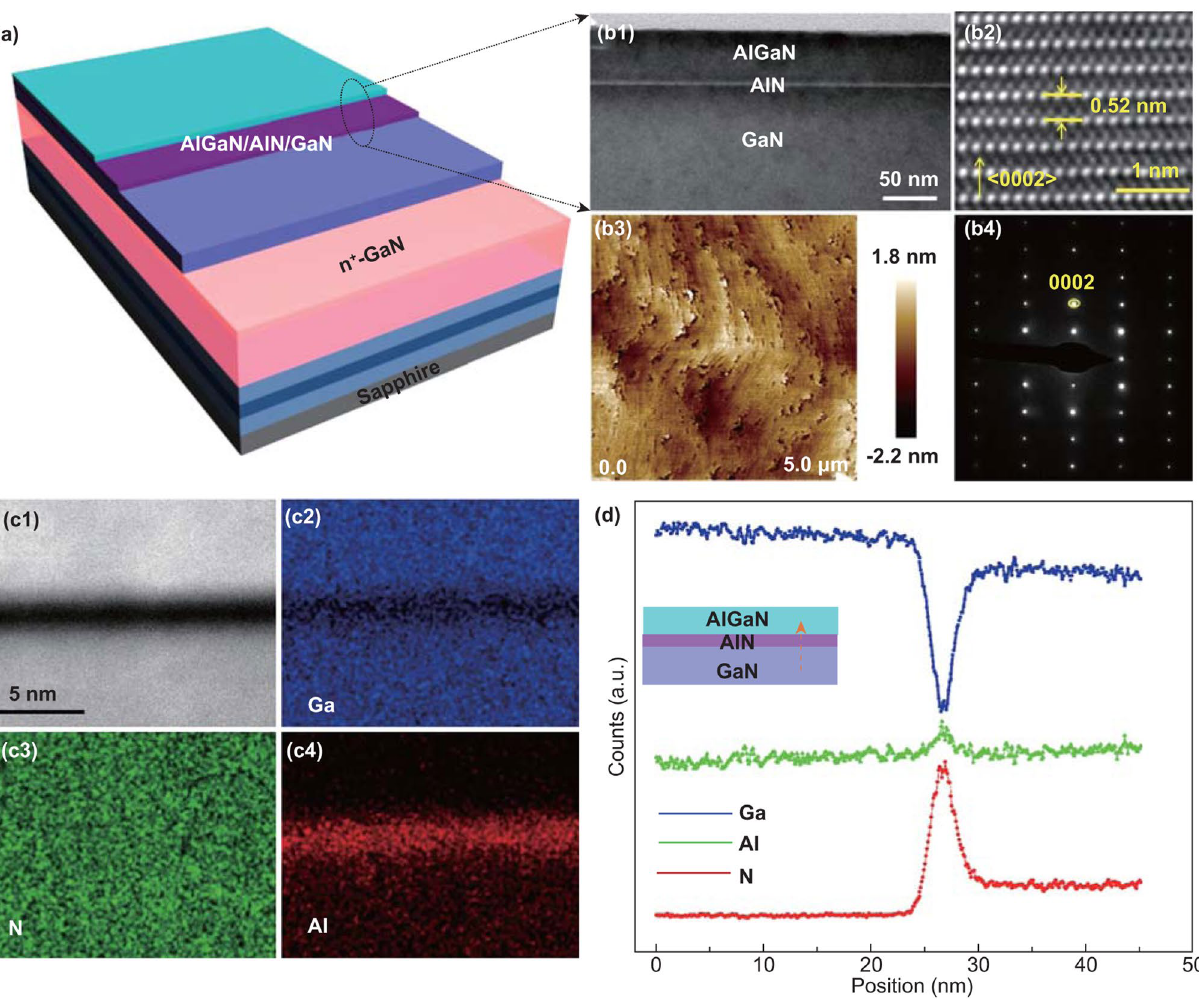
Fig. 1 Structural characterization of AlGaN/AlN/GaN heterostructure membrane. a Schematic diagram of the heterostructure membrane on sapphire. b1 The scanning transmission electron microscopy (STEM) image of AlGaN/AlN/GaN interface, the scale bar is 50 nm. b2 The high- resolution transmission electron microscope (HRTEM) image. b3 AFM image of heterostructure membrane on sapphire. b4 The selected area electron diffraction (SAED) pattern taken from the same area of HRTEM. c1 HAADF-STEM image collected from heterostructure membrane. c2 – c4 STEM energy-dispersive X-ray spectroscopy (EDX) elemental image of the AlGaN/AlN/GaN heterostructure. d The EDX line profiles for Ga (blue line), Al (green line), and N (red line)